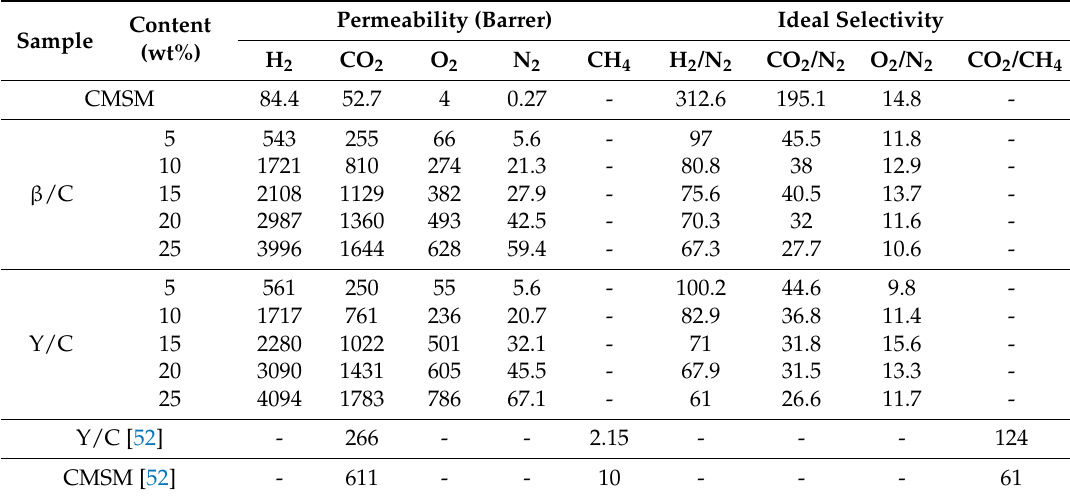
Table 4. The effect of zeolite content in the precursor on the gas separation performance of the zeolite/C hybrid membranes